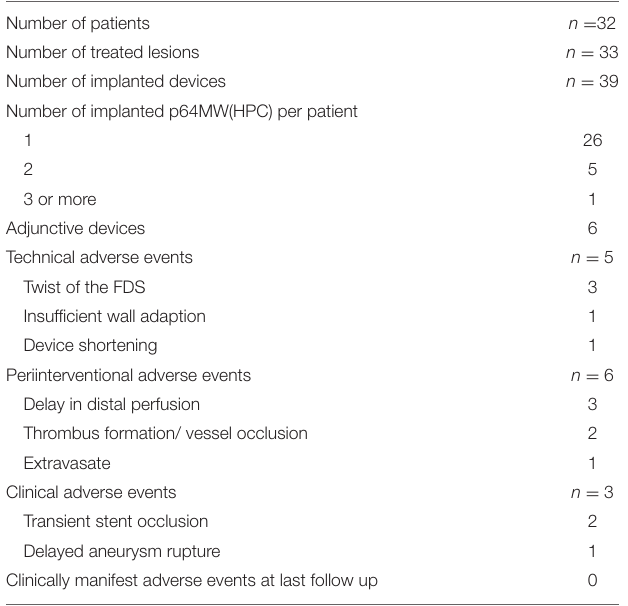
TABLE 2 | Procedural